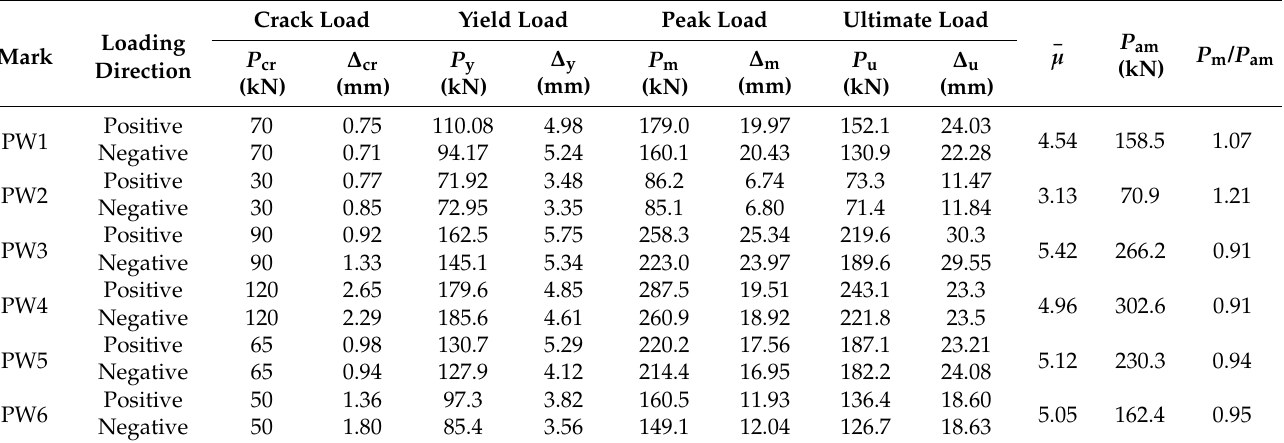
Table 3. Test results of